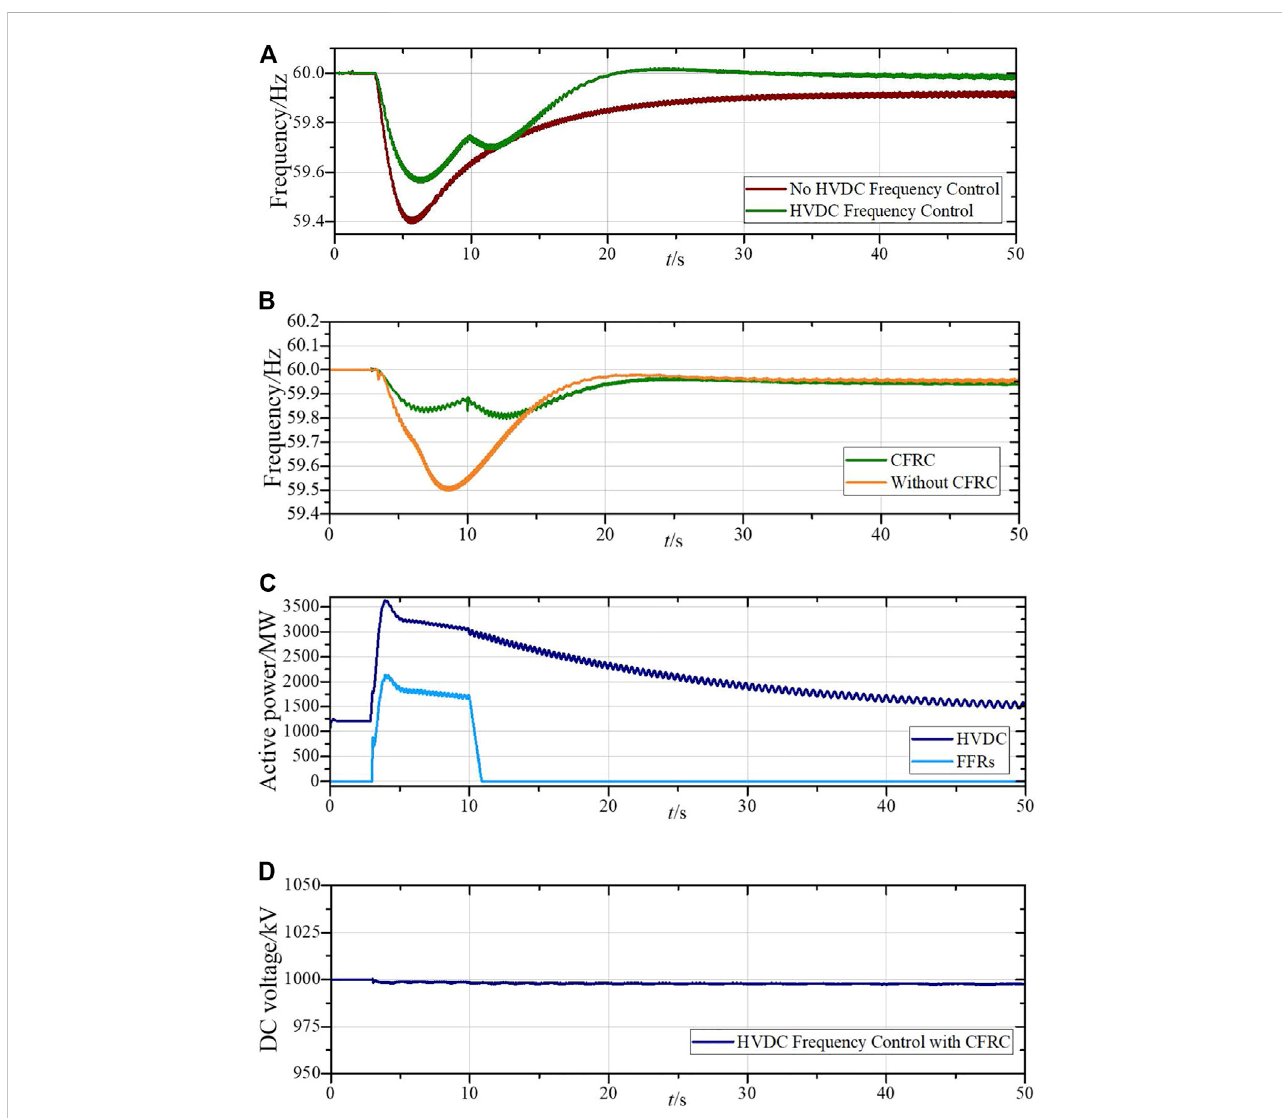
Simulation results of the VSC-HVDC system in frequency control. (A) Frequency of the EI with HVDC frequency control and without HVDC frequency control. (B) FrequencyoftheWECCwithandwithoutCFRC. (C) Power fl owontheVSC-HVDCsystemandtheoutputofFFRs. (D) DCvoltageduringtheHVDC frequency control with the